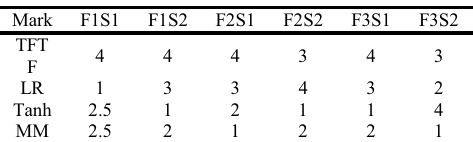
Tab.4. Performance mark comparison between different fusion methods